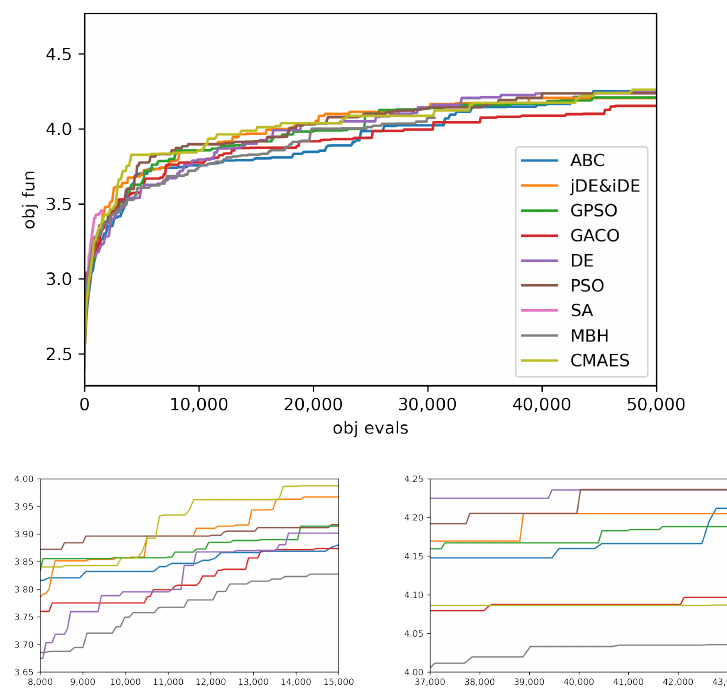
Figure 2. Average rate during fitness evaluation ( N =